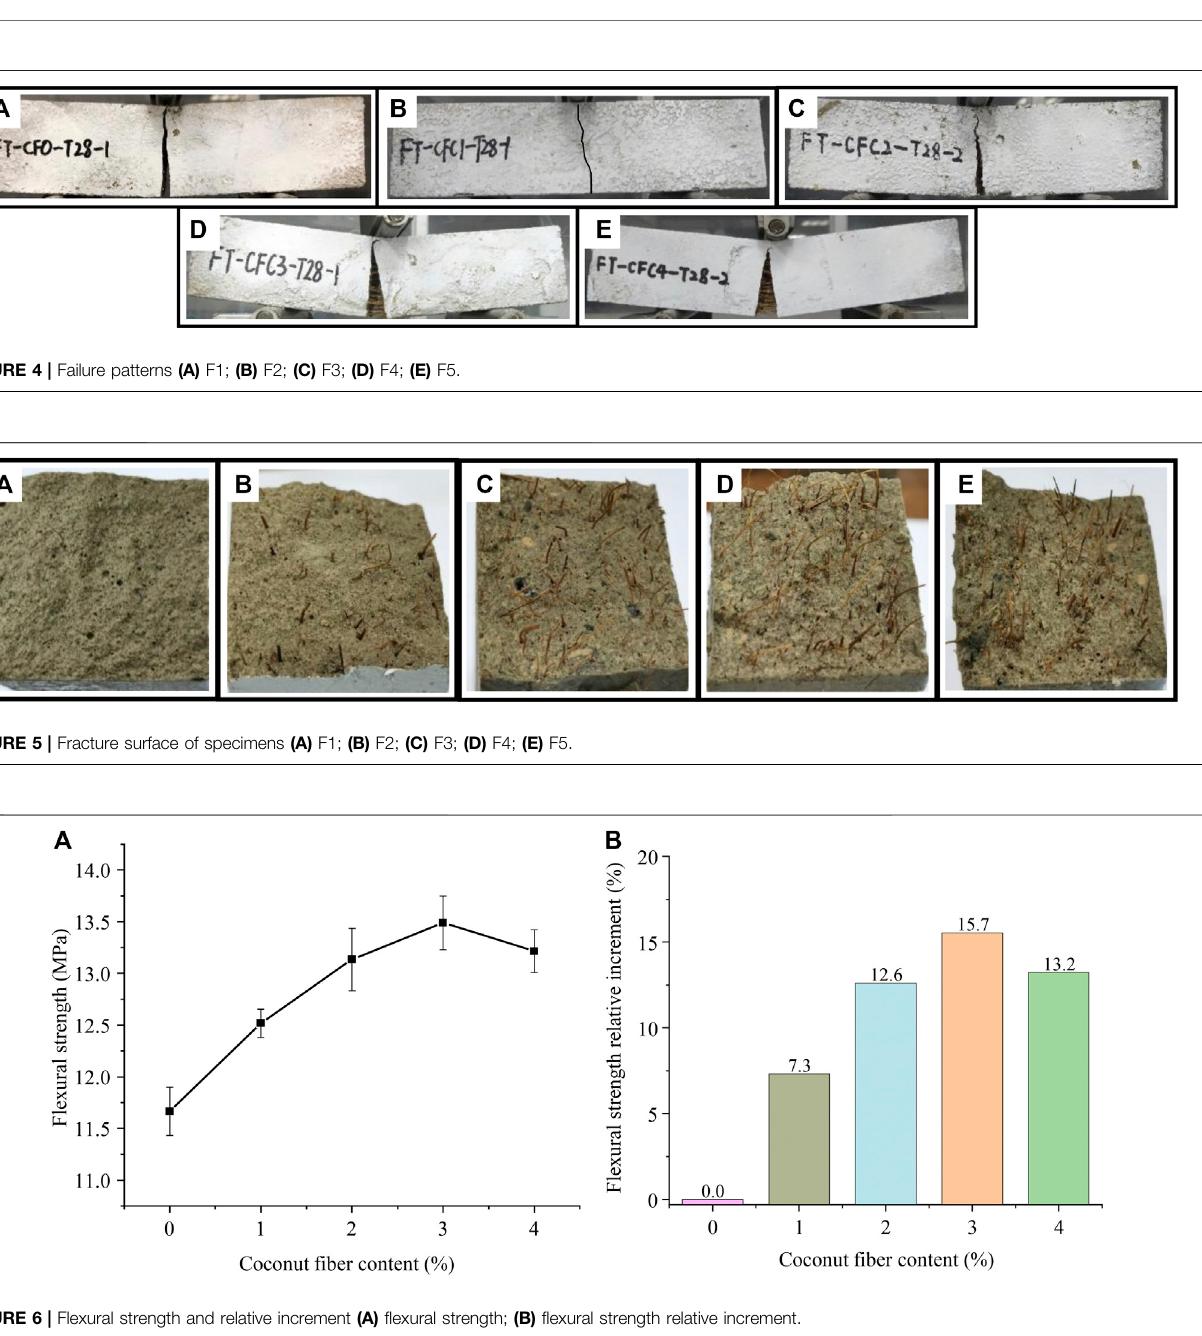
FIGURE 6 | Flexural strength and relative increment (A) fl exural strength; (B) fl exural strength relative increment.